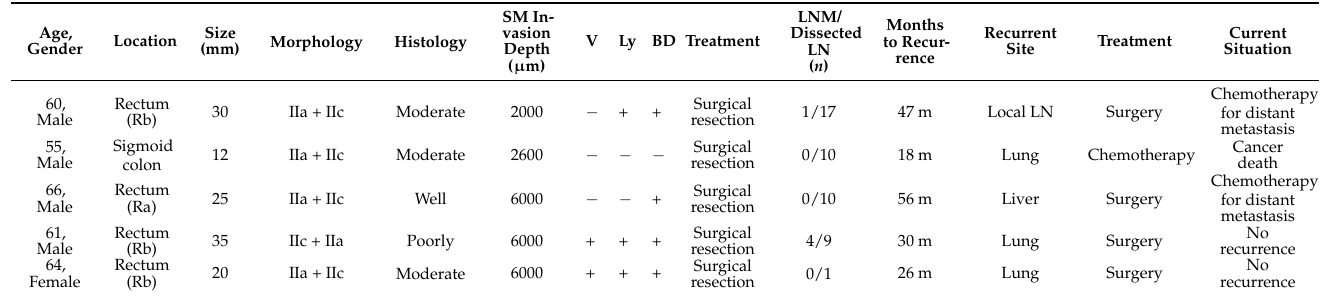
Table 5. Summary of recurrent cases.